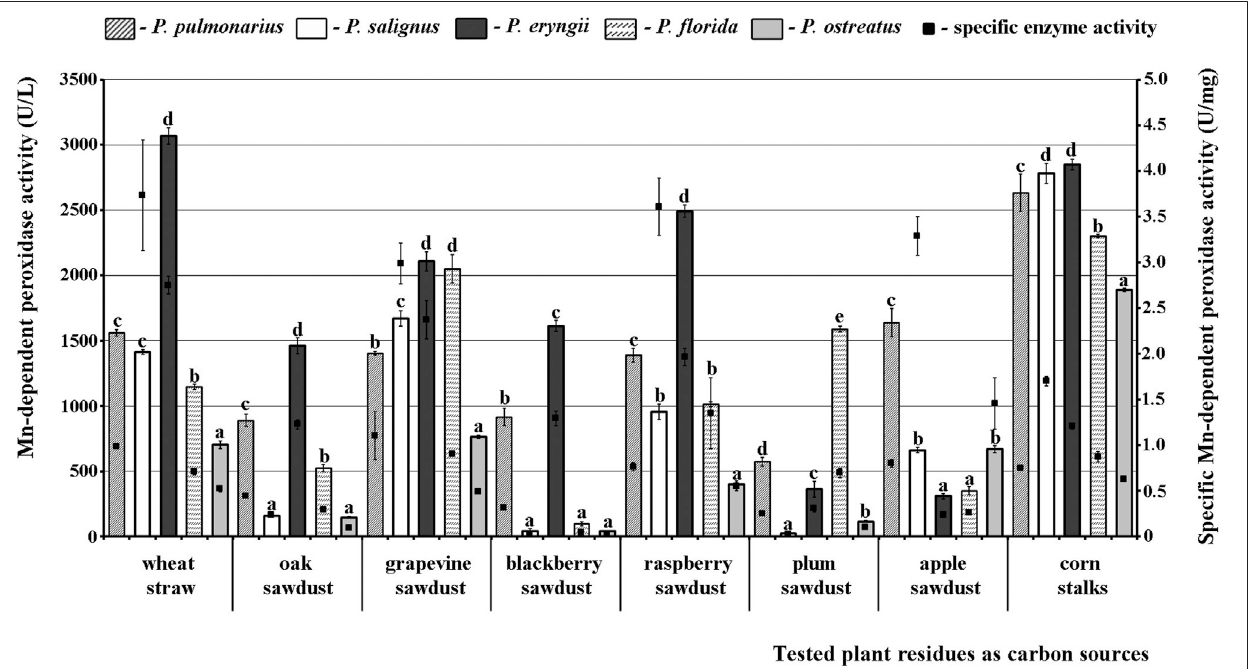
FIGURE 1 | Activity of Mn-dependent peroxidases of Pleurotus spp. depending on the type of agro-forestry residues. Values superscripted with the same letter in each values group (for each plant residue) are not signi fi cantly different ( p < 0.05).